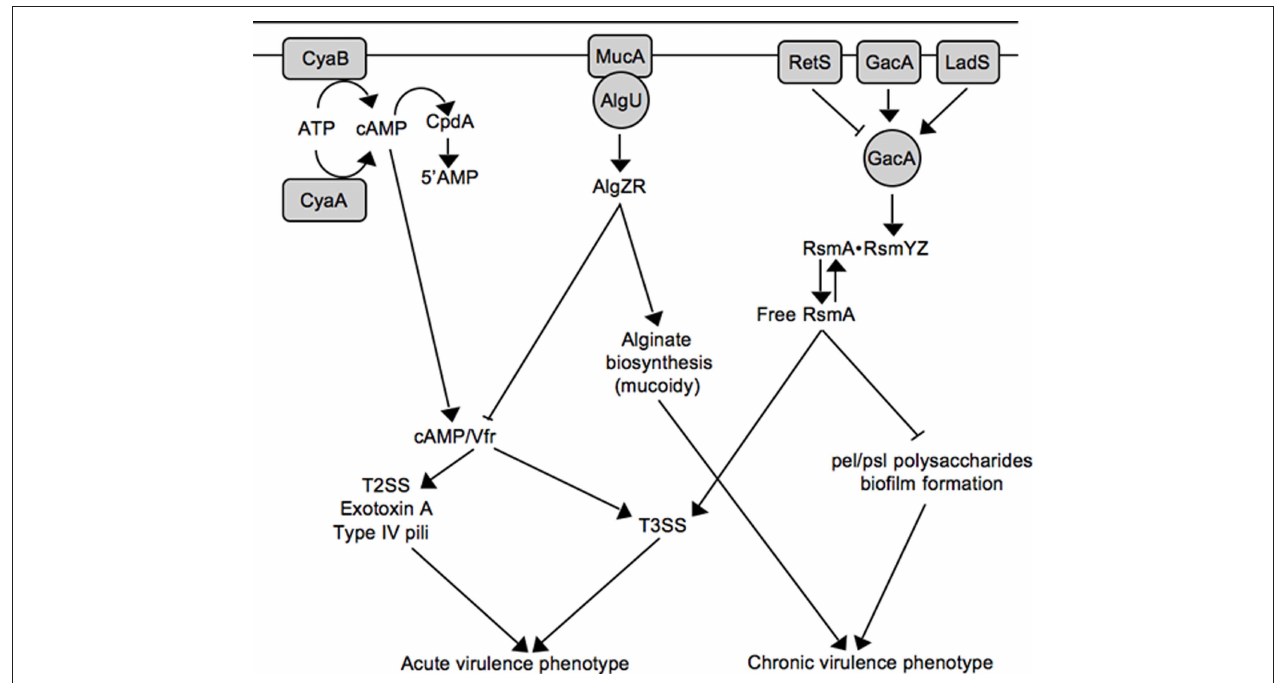
FIguRE 2 | Working model for inverse regulation of T3SS with mucoidy and biofilm formation. See text